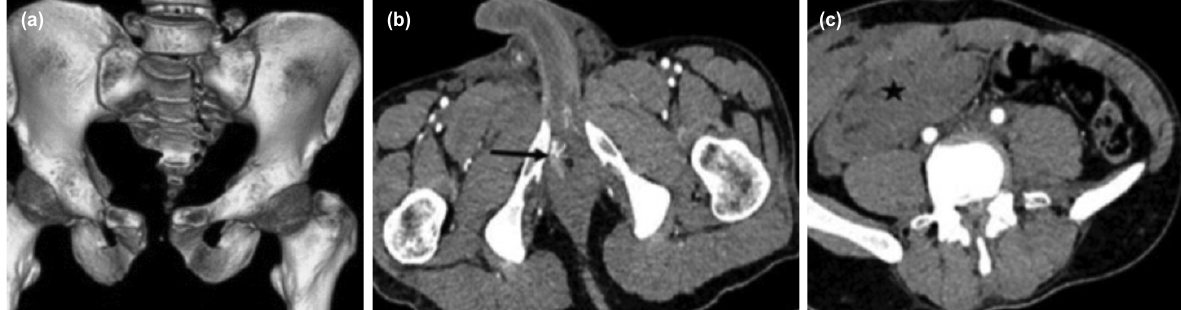
a) CT abdomen with pelvis, volume rendered image reveal fracture pattern identical to that seen on radiographs. (b) CT Fig. 2: angiography reveal a small blob of contrast extravasation (black arrow) seen in right side of corpora cavernosa close to